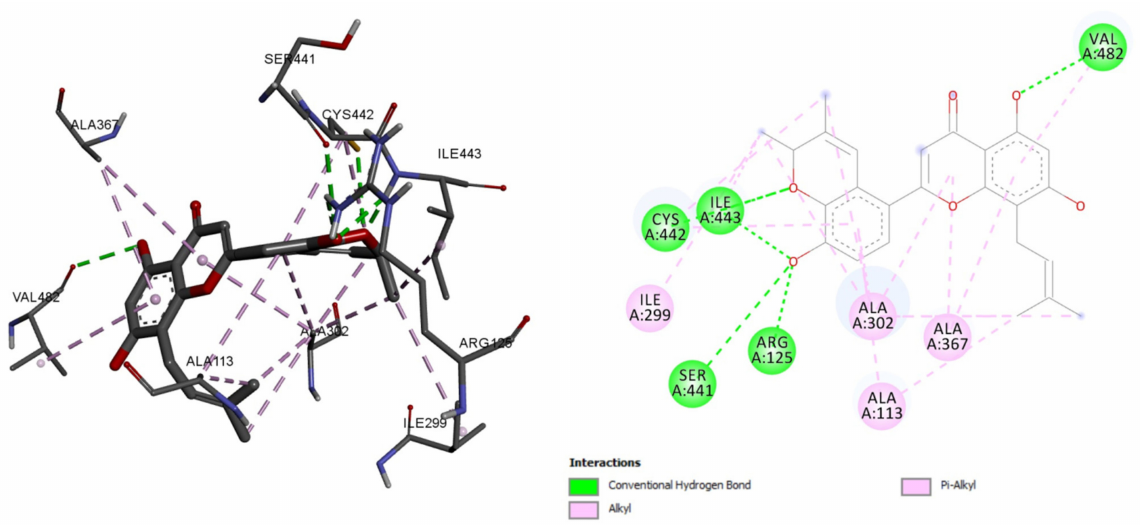
Figure 2. Morusflavone and its molecular interaction with CYP17A1. The residues associated with the abiraterone–CYP17A1 molecular interaction were GLY, CYS, ILE, LEU, ALA, VAL, and LEU, whereas the residues which formed hydrogen bonds were GLY, CYS, and ILE. The LEU residue also formed Pi-lone pairs. However, ALA, VAL, LEU, and ILE were associated with Alkyl and Pi-alkyl bonds (Figure 3). The common residues between Morusflavone–CYP17A1 and abiraterone–CYP17A1 were ILE and CYS for hydrogen bonds; and ILE, and ALA for alkyl and Pi-alkyl bonds, respectively. The details of the molecular interaction analysis are given in Table 1.